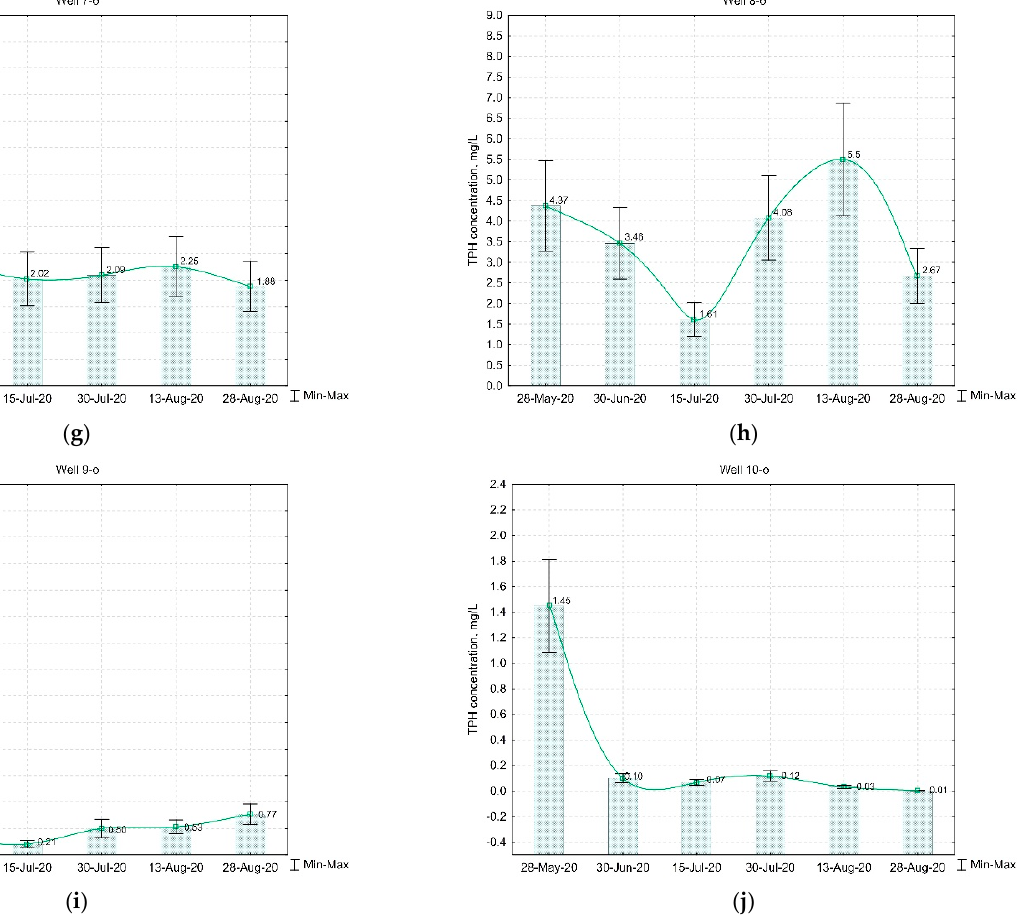
Figure 8. Total petroleum hydrocarbon concentration in groundwater during field test (well 1—( a ); well 2—( b ); well 3—( c ); well 4—( d ); well 5—( e ); well 6—( f ); well 7—( g ); well 8—( h ); well 9—( i ); and well 10—( j )).